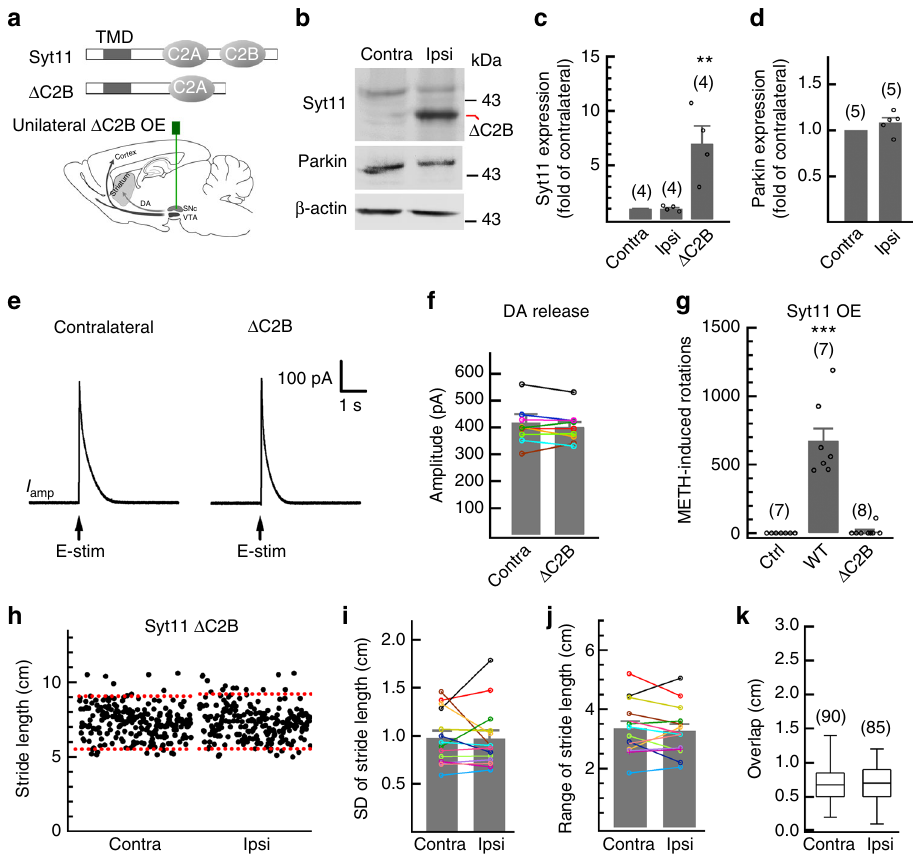
Fig. 6 Overexpression of C2B-truncated Syt11 in the SNpc fails to mediate de fi cits in DA release and motor behavior. a Schematic of unilateral overexpression of C2B-truncated Syt11 ( Δ C2B) in the SNpc with an AAV9-expressing system. b Representative western blots showing the expression of parkin and Syt11 in the bilateral SNpc from mice with unilateral overexpression of Δ C2B as in a . Western blots were performed 1 month after virus injection. c , d Statistics of Syt11 ( P = 0.002) and parkin ( P = 0.196) expression in the SNpc from mice as in b . e , f Representative amperometric currents ( I amp ) and statistics showing the intact DA release from Δ C2B-overexpressing dopaminergic terminals in the striatum ( P = 0.332, n = 9 pairs in slices from fi ve mice). g METH-induced asymmetric rotations (in 90 min) of control (Ctrl), full-length Syt11 (WT), and Δ C2B-Syt11 overexpressing mice ( P < 0.001). h – k Footprint data showing that unilateral overexpression of Δ C2B in the SNpc fails to induce a motor defect in the contralateral limbs (SD, P = 0.900; range, P = 0.516; overlap, P = 0.917, n = 90 Contra and 85 Ipsi steps from 7 mice). Dashed red lines show the 5 and 95% percentiles of stride length in h . Data are shown as mean ± s.e.m for c , d , f , g , i , j . Paired Student ’ s t -test for d , f , i , j ; one-way ANOVA for c , g ; Mann – Whitney test for k , box and whisker plots show medians (central line in the box), ranges between 25th and 75th percentiles (box) and minimum – maximum ranges (whiskers). * P < 0.05, ** P < 0.01, *** P <